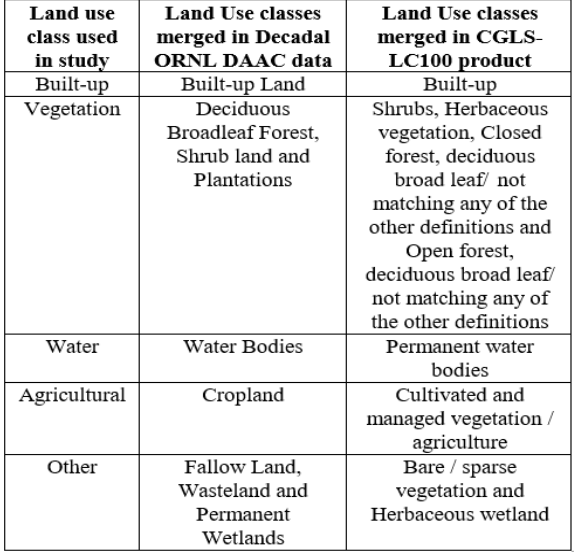
Table 1. Land use classes reclassified in the study.